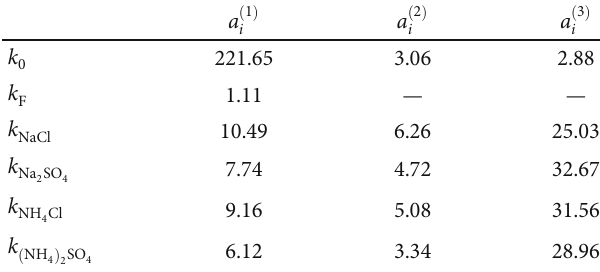
Table 1: Parameters describing the dependence of k c Lys , cf. Equations (3)